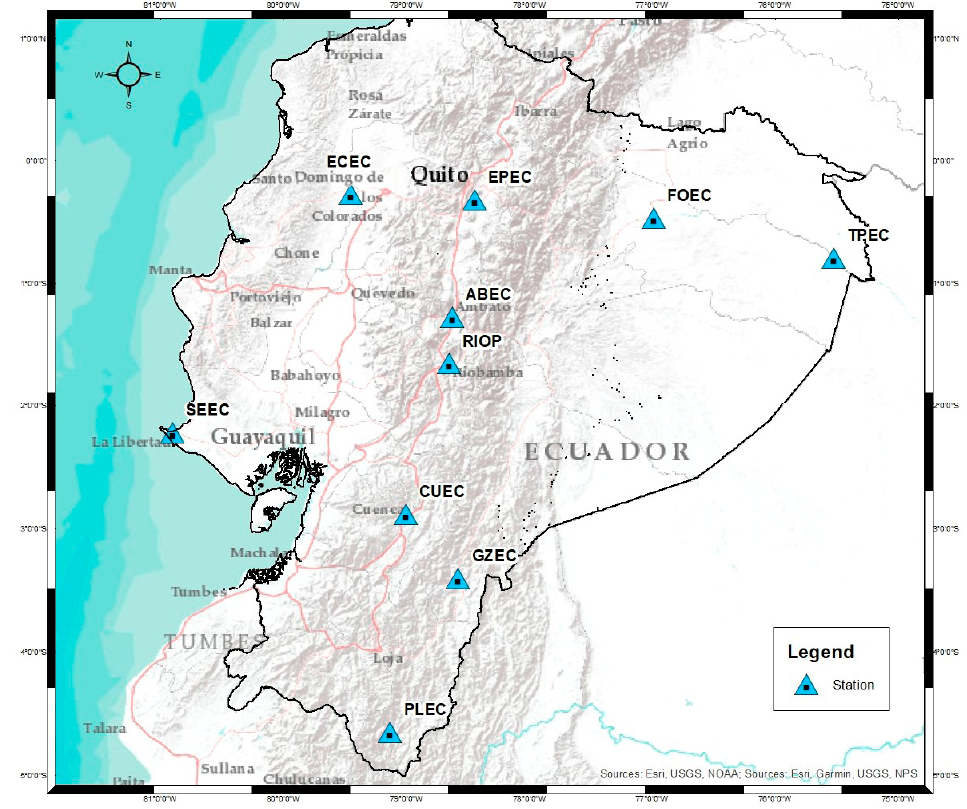
Figure 4. The location of the stations analyzed on the Ecuadorian territory. Each station is part of the REGME (The Ecuadorian GNSS permanent network). It was sought to cover the entire Ecuadorian territory with the selected stations as long as their data met optimal quality levels for temporal analysis. As can be seen on the map, there are 2 stations in the coastal region, 6 stations along the Andes, and 2 stations in the Ecuadorian Amazon.